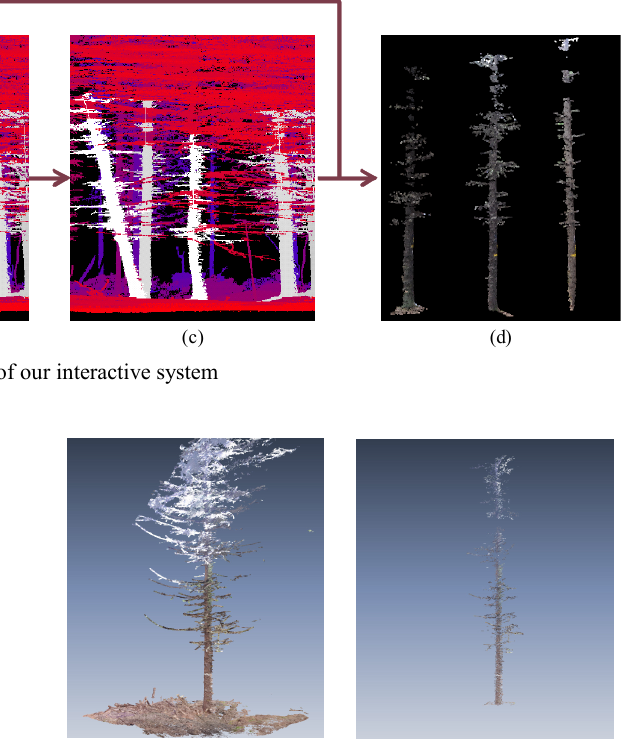
Fig.6 An example of extraction results of a single trunk (left: entire tree, right: tree